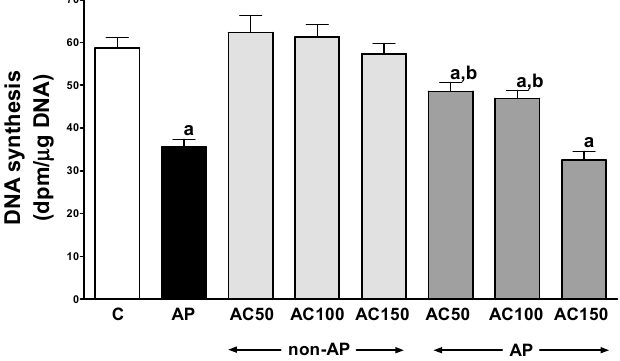
Figure 5. Impact of pretreatment with acenocoumarol on pancreatic DNA synthesis in rats with or without cerulein-induced pancreatitis. Key: C = control; AP = cerulein-induced acute pancreatitis; non-AP = groups without induction of acute pancreatitis; AC = acenocoumarol; 50 = 50 µg/kg/day; 100 = 100 µg/kg/day; 150 = 150 µg/kg/day. Mean ± SEM. n = 10 in each group of rats. a p < 0.05 compared to control; b p < 0.05 compared to AP alone.